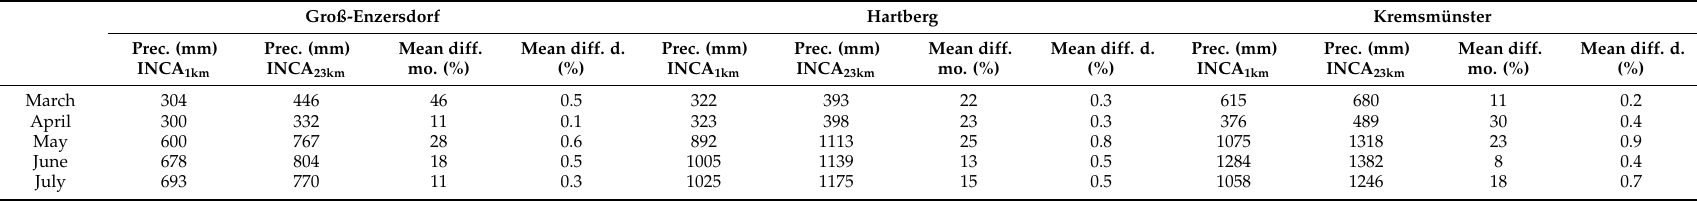
Table 4. Monthly precipitation sums and mean differences of rainfall (monthly and daily) between INCA 1km and INCA 23km for the months March until July 2007–2015.